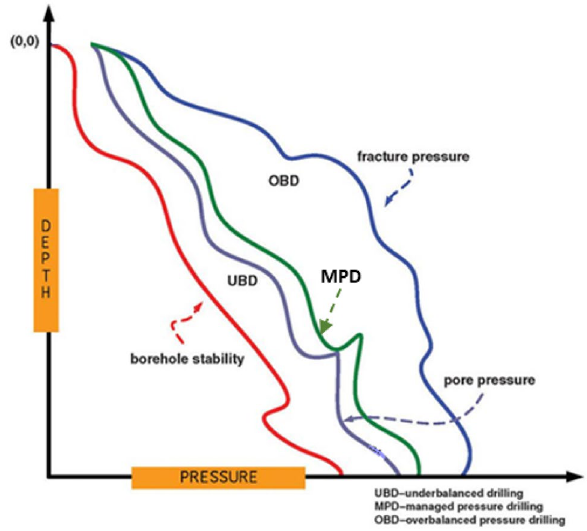
Fig. 1 Drilling mud window; pressure vs. depth. (Modified after Deepak Gala